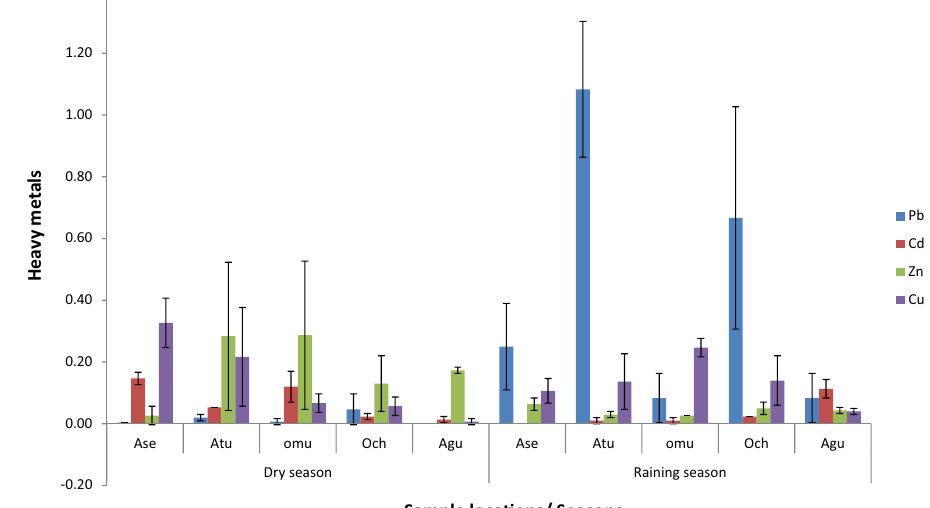
Fig. 3 Seasonal variations of the trace metal content